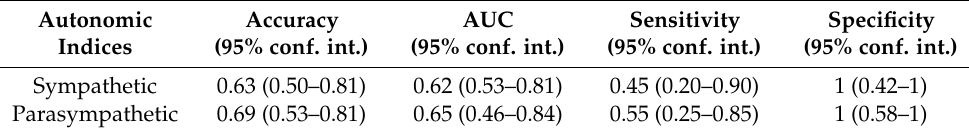
Table 2. Classification performances of cardiac autonomic